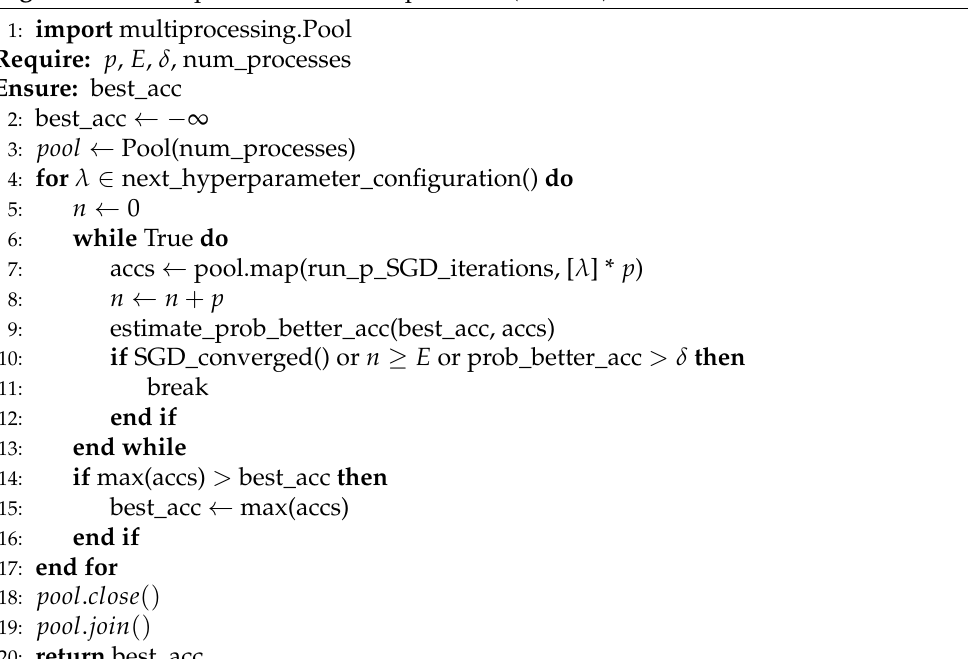
Algorithm 3 Extrapolation Method Optimized